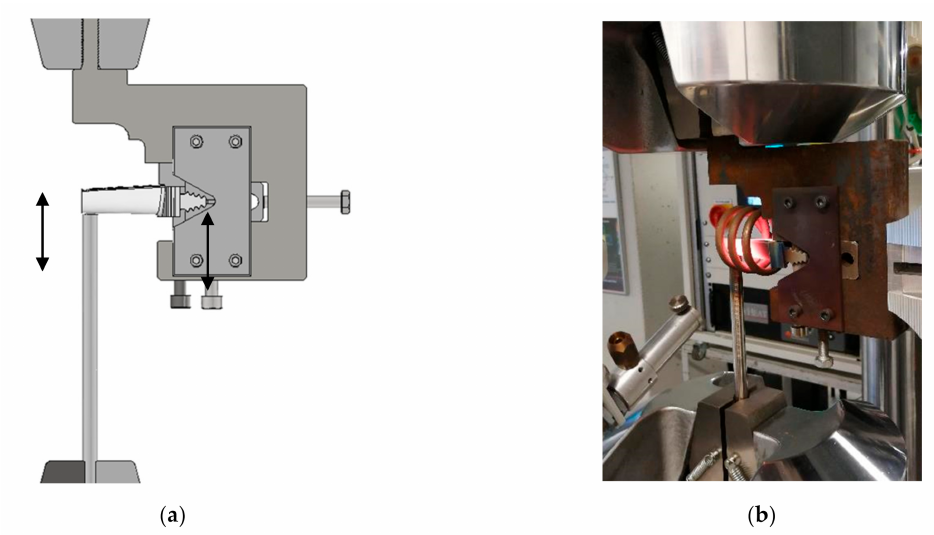
Figure 3. Schematics of a turbine blade grip ( a ) and its general view during the experiment ( b ). Microstructural characterization and chemical composition analysis of the turbine blades were examined using Hitachi 2600 N scanning electron microscope with energy dispersive spectroscopy (EDS) attachment (Oxford Instruments, Oxford,